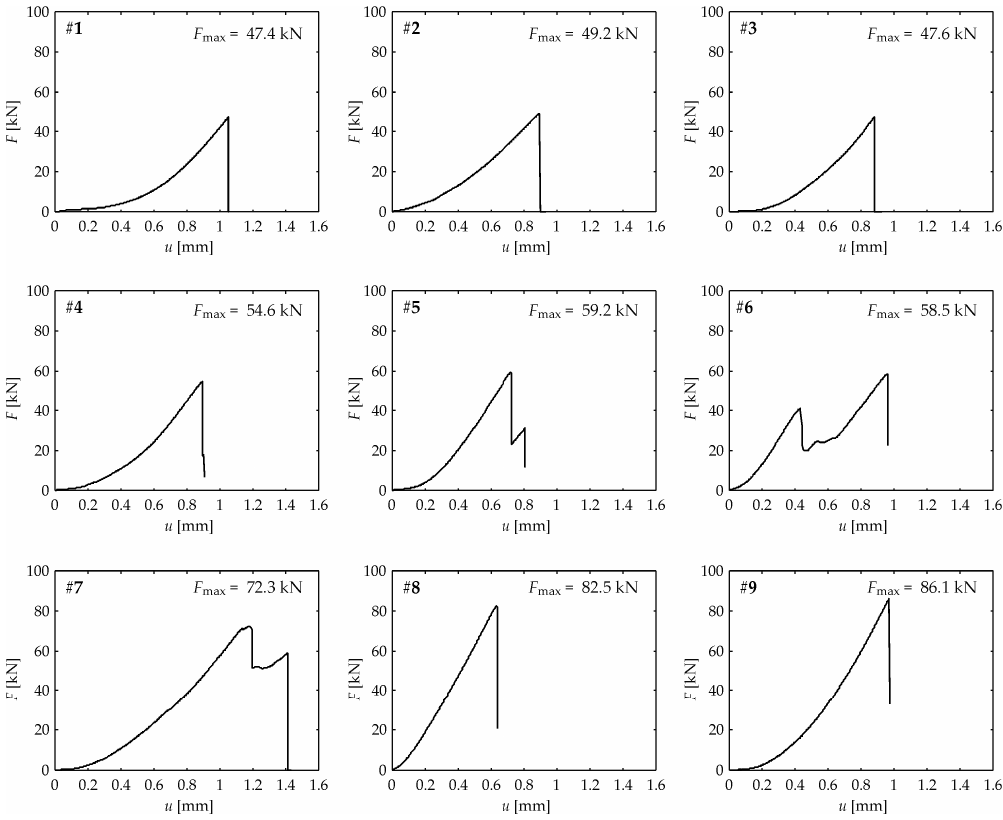
Figure 8. Experimental force-displacement ( F - u ) curves of tested push-out specimens ( #1 – #9 ).